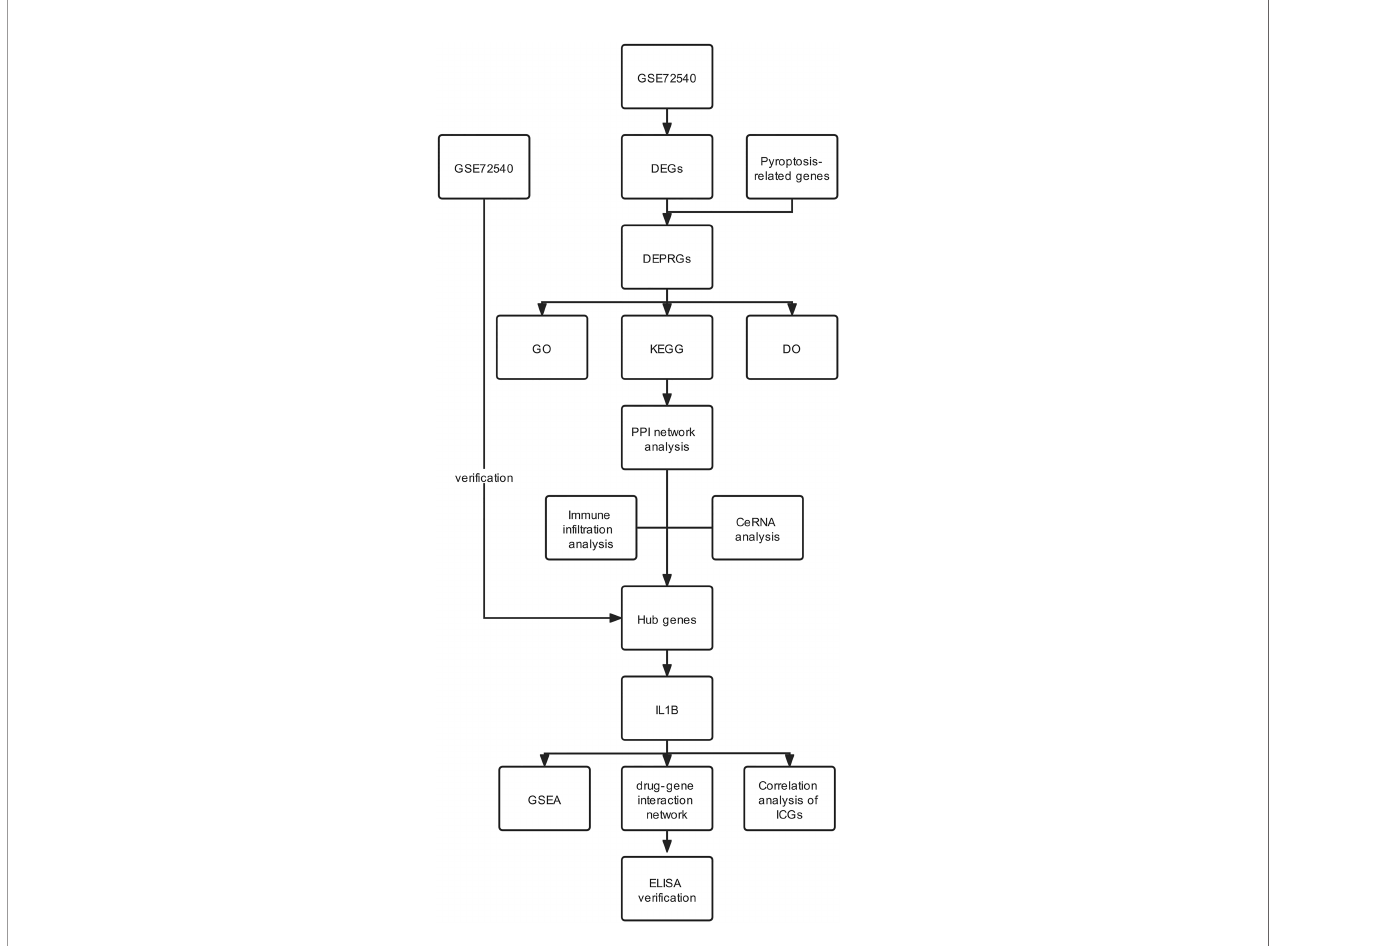
FIGURE 1 | Flowchart of the study.